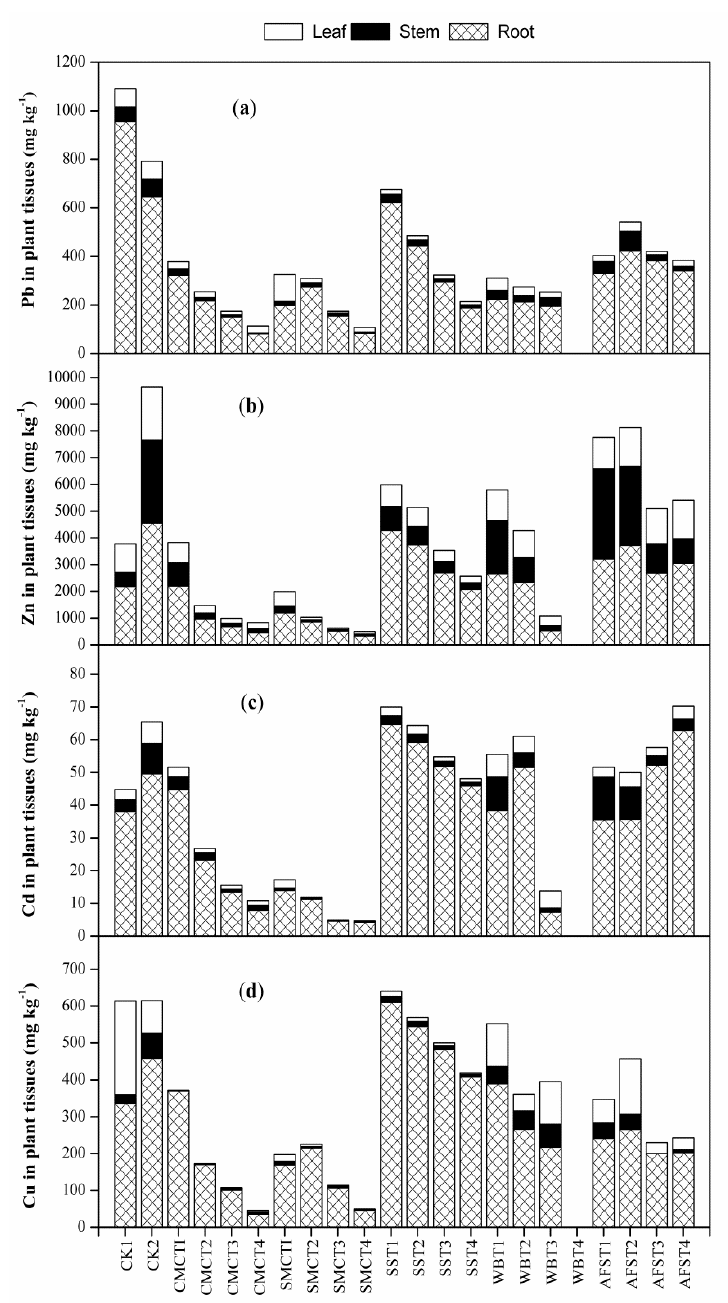
Figure 2. Effect of amendments on concentrations of Pb ( a ), Zn ( b ), Cd ( c ) and Cu ( d ) in A. fruticosa tissues grown in treated tailings. Letters above the bars refer to the difference at significance level ( p < 0.05, LSD) among different treatments. CK1: Control 1; CK2: Control 2; CMC: Cattle manure compost; SMC: Spent mushroom compost; SS: Sewage sludge; WB: Wood biochar; AFS: Agricultural field soil. Plant did not grow in WBT4.